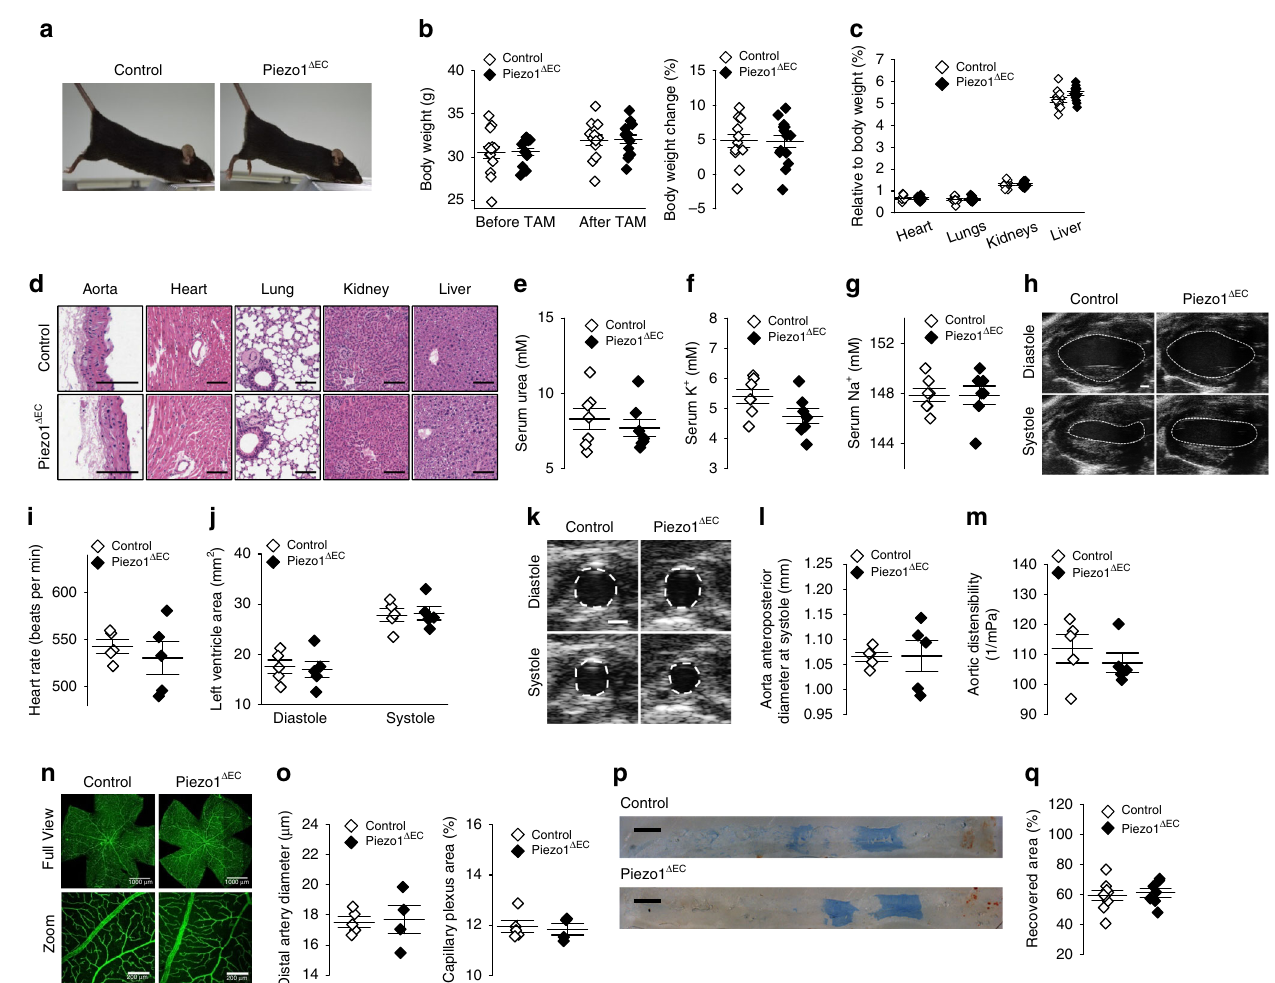
Fig. 1 Mice with disrupted endothelial Piezo1 are super fi cially normal. a Physical appearance of control and endothelial Piezo1-deleted (Piezo1 Δ EC ) mice. b Body weight and percentage change in body weight of control ( n = 13) and Piezo1 Δ EC ( n = 14) mice before and 10 – 14 days after tamoxifen (TAM) treatment. c As percentages of total body weight, weights of heart, lung, kidney and liver in control ( n = 13) and Piezo1 Δ EC ( n = 14) mice. d Histological examples of control ( top row ) and Piezo1 Δ EC ( bottom row ) sections of aorta, heart, lung, kidney and liver stained with H&E. Scale bars 100 μ m. e – g Serum concentrations of urea, K + and Na + in control ( n = 7) and Piezo1 Δ EC ( n = 7) mice. h – m Ultrasound study of the heart h – j and aorta k – m of control ( n = 5) and Piezo1 Δ EC ( n = 5) mice under anaesthesia. h Example of left ventricle images of control and Piezo1 Δ EC at diastole and systole. The left ventricle chamber is circled with a white dashed line . Scale bar 1 mm. i , j Cardiac parameters measured by ultrasound. k Example of aorta images of control and Piezo1 Δ EC at diastole and systole. The left ventricle chamber is circled with a white dashed line . Scale bar 1 mm. l Aorta anteroposterior diameter at systole. m Aortic distensibility. n Retinal vasculatures stained with isolectin ( green ) from control and Piezo1 Δ EC mice. Entire retinas ( full view ) and close up views ( zoom ). o Quanti fi cation of retina distal artery diameter and capillary plexus area from control ( n = 5) and Piezo1 Δ EC ( n = 4) mice. p Endothelial regeneration 5 days after femoral artery injury. Images of the arteries in which the blue colour shows Evans blue staining of areas which were not re- endothelialized after injury. Scale bars 0.5 mm. q Quanti fi cation of endothelial regeneration in control ( n = 9) and Piezo1 Δ EC ( n = 7) mice. Independent data points are displayed with superimposed bars indicating mean ± s.e.m. Data sets are compared by t -test. No signi fi cant differences were